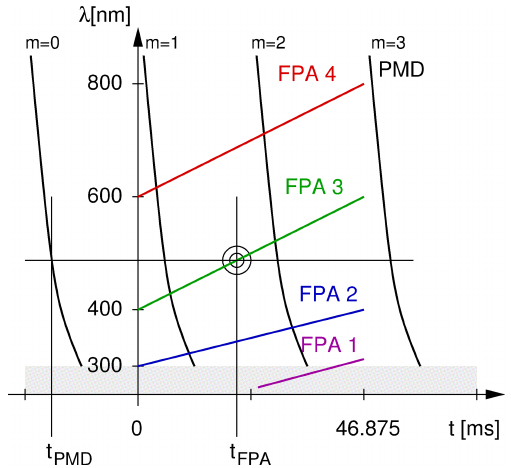
Figure 8. Timing diagram for main channel and PMD detector pixel read-outs. For this example, read-out sequence “up” has been as- sumed for the four main channels, and read-out sequence “down” for the two PMD channels. Readout of the main channels and read- out of the PMD channels for m = 1 starts at t = 0. For a given de- tector pixel in a main channel, indicated by the circles, its read-out time t FPA and the one of the PMD pixel closest in wavelength, t PMD are determined. The difference between the two times is then used for linear interpolation of the PMD data between the two adjacent PMD